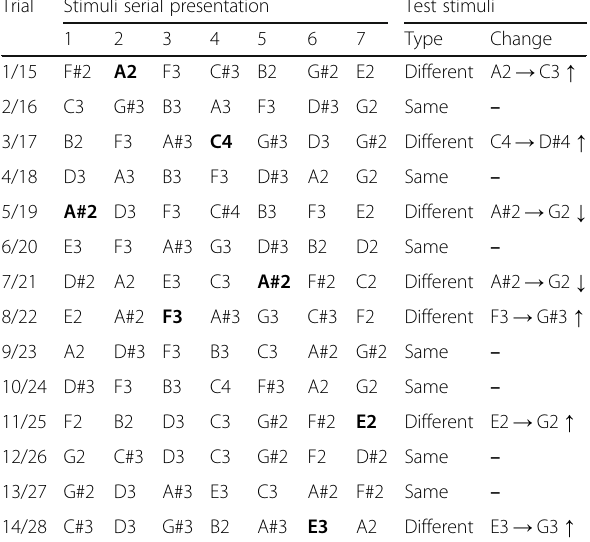
Table 2 The fourteen sequences of seven tones used in each one of the trials, with the type of test-sequence (the same or different as the memorized sequence) and the discrepant tone (above [ ↑ ] or below [ ↓ ] the respective original tone) in the “ dif- ferent ” trials